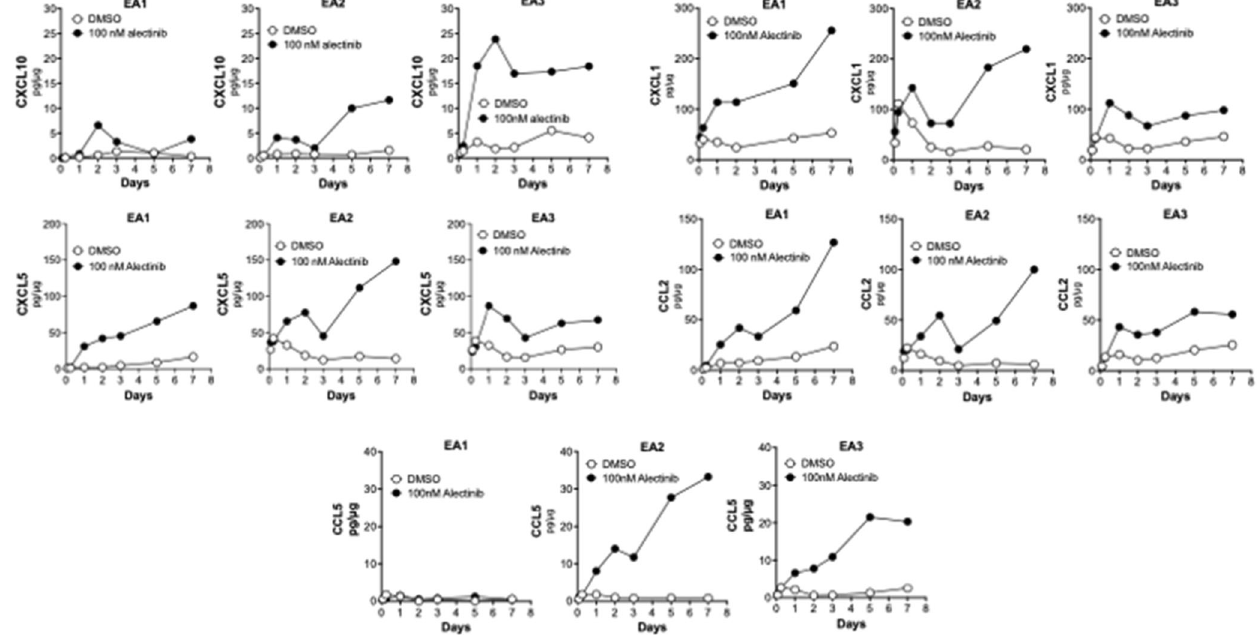
Fig. 6 Chemokine induction with alectinib treatment in murine EML4-ALK cell lines. EA1, EA2, and EA3 cells were treated in vitro with 0.1% DMSO or 100 nM alectinib for 2 h to 7 days. The culture medium was collected and submitted to ELISA for the indicated chemokines. The data are presented as pg of analyte per μ g cell protein and are representative of two independent